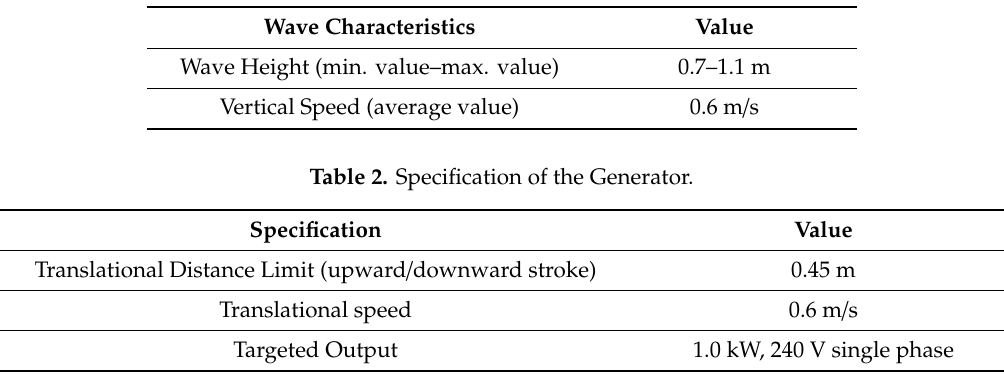
Table 1. Wave Characteristics in South China Sea, Malaysia [5].